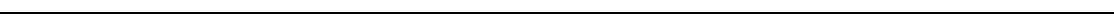
Fig. 4 Subpopulations of β 2 AR display distinct structural properties. a Schematic of SiMPull with phospho-speci fi c antibody against FLAG-mYFP- β 2 AR and examples of fl uorescent time traces depicting one- or two-step photobleaching of mYFP- β 2 ARs, which provides stoichiometric information of β 2 AR. The composition of β 2 AR was calculated based on photobleaching steps in different conditions described in b and c . b Cells are stimulated with different concentrations of ISO for 5 min, the total β 2 ARs were pulled down for photobleaching analysis, displaying a composition of ~40% dimers and ~60% monomers independent of agonist stimulation (mean ± s.d.; n = 10, 8, 10, and 8 independent experiments, respectively). c The PKA- and GRK- phosphorylated β 2 ARs were pulled down with phospho-speci fi c antibodies against S261/262 (PKA-p β 2 AR) and S355/356 (GRK-p β 2 AR) with different concentrations of ISO as indicated. At 1 nM, ISO only induces PKA-phosphorylation of β 2 AR but not GRK-phosphorylation of β 2 AR; higher concentrations of ISO induce both PKA- and GRK-phosphorylation of β 2 ARs. PKA-phosphorylated β 2 ARs display a composition of nearly 70% dimers and 30% monomers upon stimulation with all tested concentration of ISO (mean ± s.d.; n = 6, 6, and 14 independent experiments, respectively), whereas GRK-phosphorylated β 2 ARs display a composition of 12% dimers and 88% monomers at high concentrations of ISO stimulation (mean ± s.d.; experiments, respectively). N.A. not